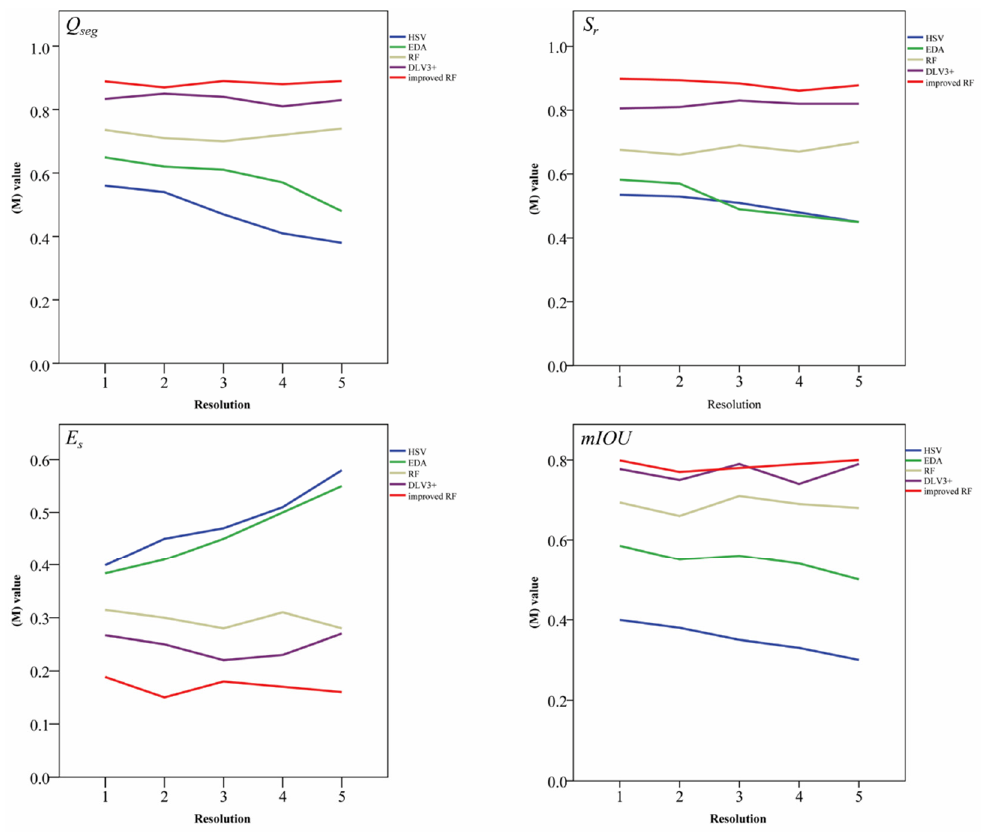
Figure 6. Results of image segmentation models for different image resolutions. The color lines in each box represent how the indices vary as image resolution when using different methods. Panels 1–5 correspond to image resolution ranging from high to low.